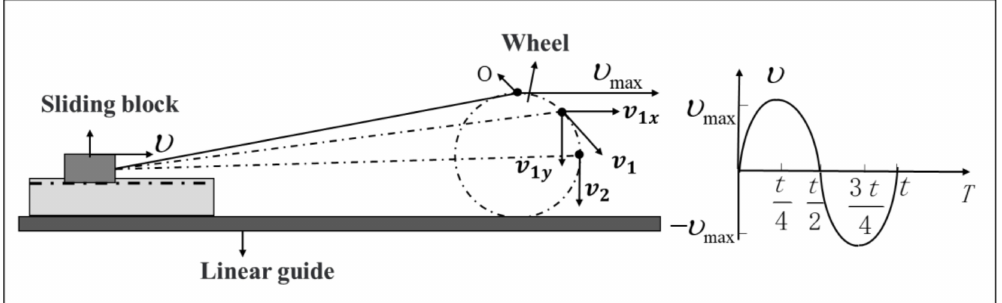
Figure 13. Variation curves of movement speed of sliding blocks.